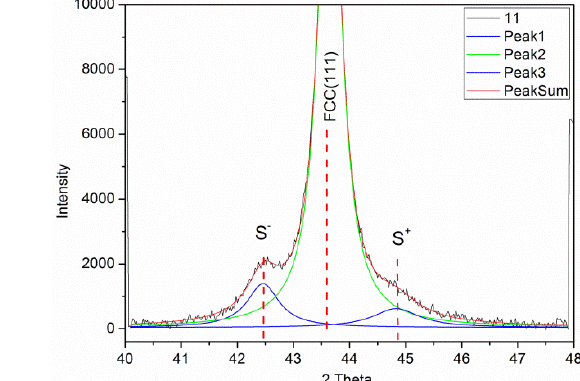
Figure 2. XRD pattern (black line) around the fcc(200) reflection (left panel) and around the fcc(311) reflection (right panel) for the Ni-Co/Cu multilayer with t Cu = 1.5 nm thick spacer layer (sample 22). The green line represents the fit for the main reflection (peak 2), and the blue lines represent the fits for the lower-angle satellite peak S − (peak 1) and the higher-angle satellite peak S + (peak 2). The red line is the sum of the three fitted peaks. From the satellite peak positions, the bilayer length was obtained as  Λ XRD = 4.7 nm for the (200) reflection and Λ XRD = 4.6 nm for the (311) reflection. The satellites around the main reflection (111) yielded Λ XRD = 4.5 nm whereas the nominal bilayer length was Λ nom = 3.5 nm.